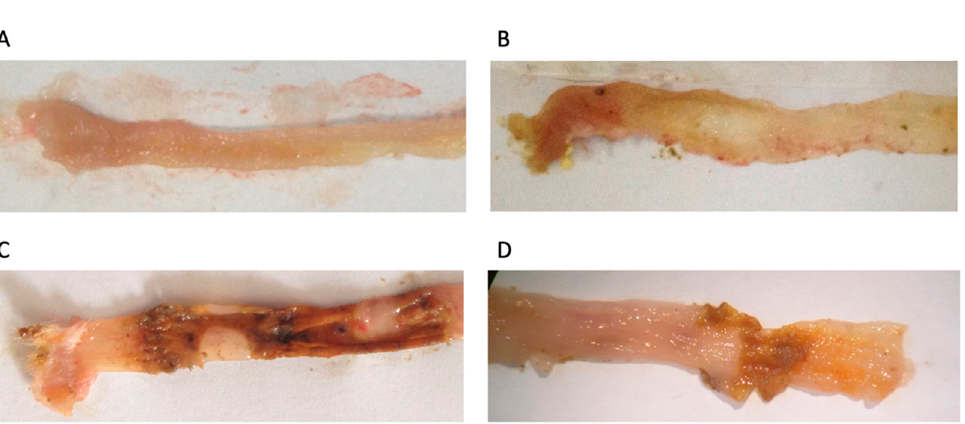
Figure 4. Effect of Summer Savory extract administration on the macroscopic characteristic of colon. ( A ) Sham group ( n = 6), ( B ) EtOH group ( n = 6), ( C ) TNBS group ( n = 10), ( D ) TNBS + Summer Savory extract ( n = 10).